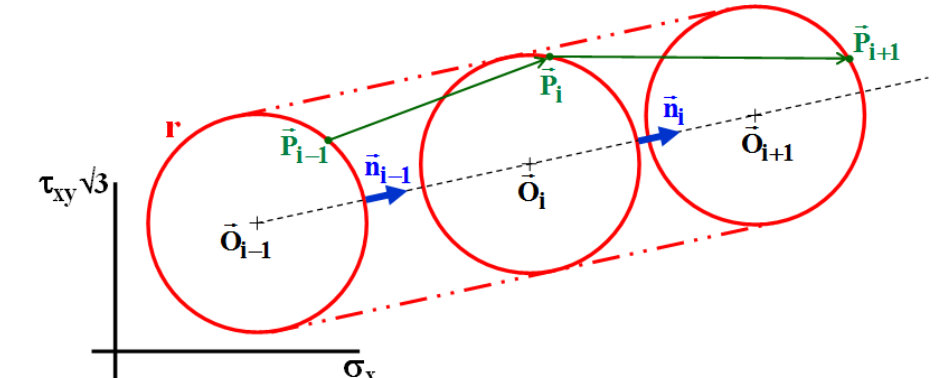
   n n , caused by the path  1 i i